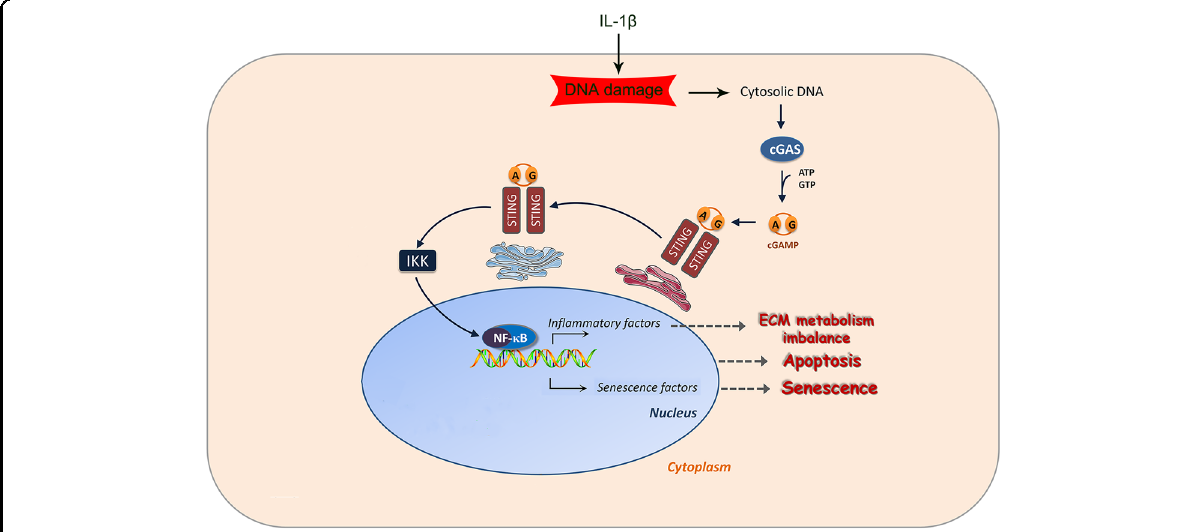
Fig. 8 Schematic illustration of effect of cGAS-STING in osteoarthritis